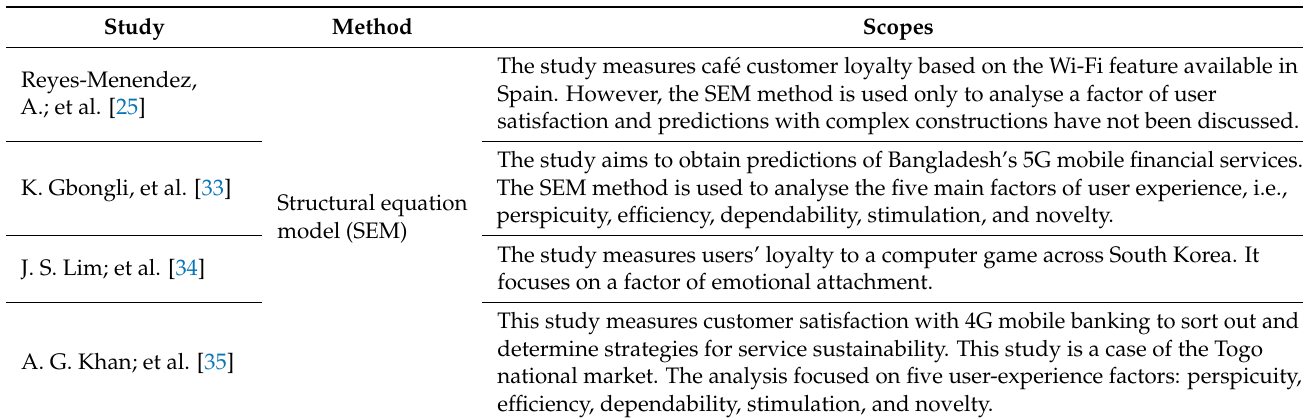
Table 1. Summary of the most relevant previous studies.